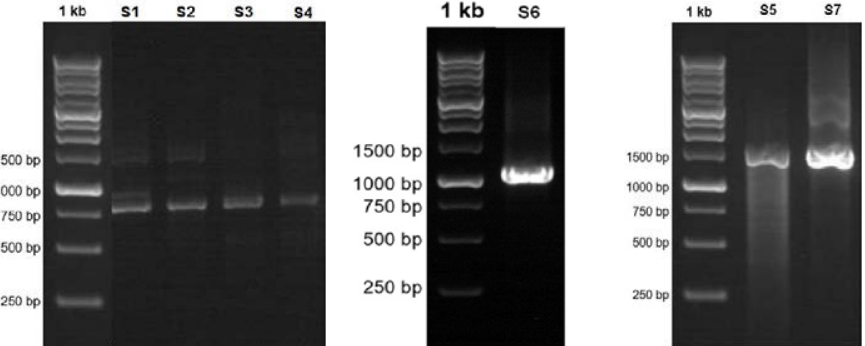
Fig. 1. Visualization of the 16S RNA gene amplicon of seven bacterial isolates from flies in Luwuk City, Central Sulawesi,